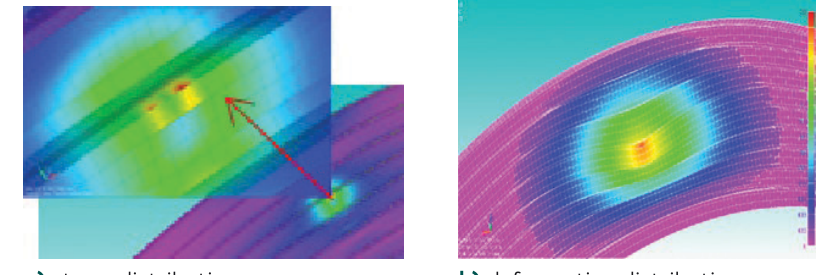
Figure 8. Stress-deformed state of a transport construction made of corrugated metal structure reinforced with stiffening